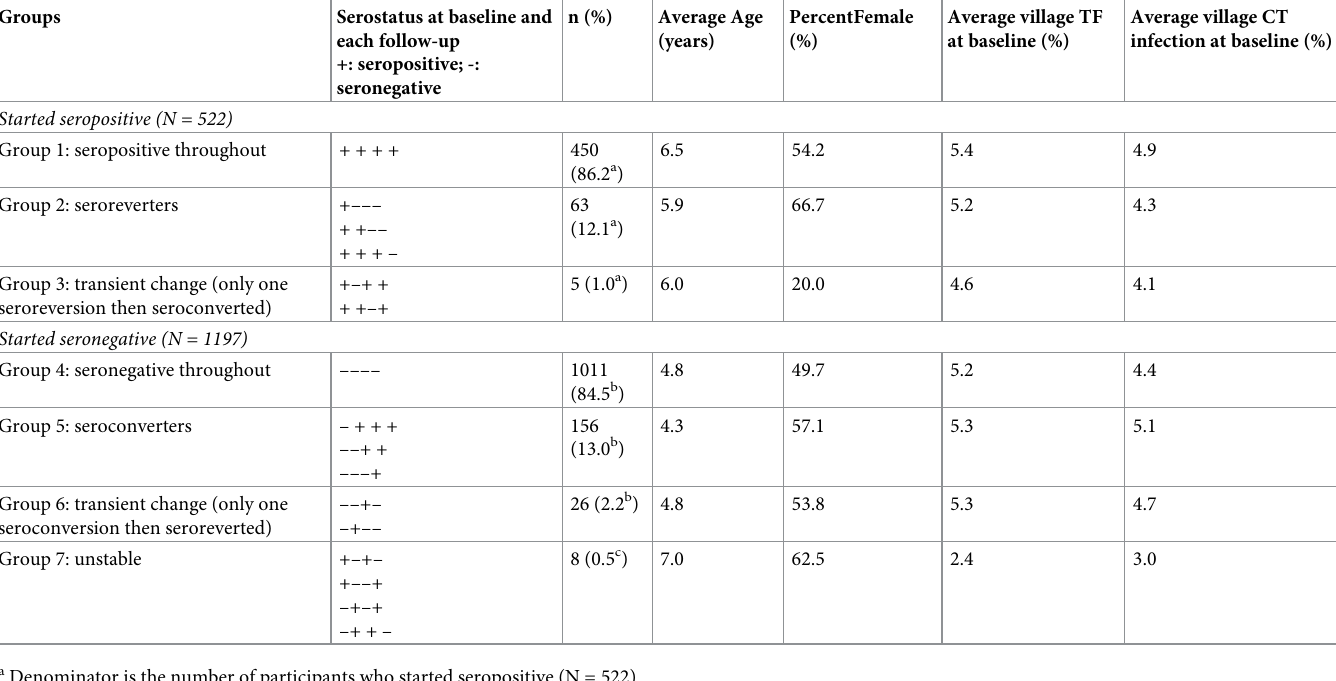
Table 3. Characteristics of the cohort divided into each longitudinal serostatus group. Groups